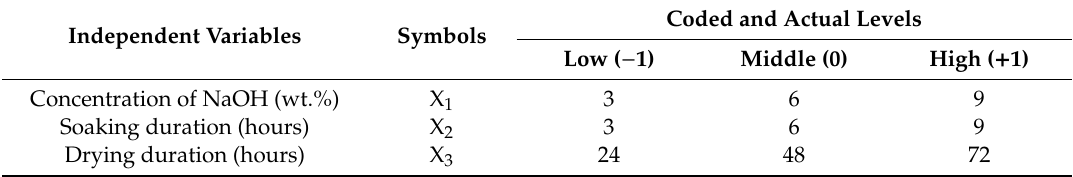
Coded and Actual Levels Low ( − 1) Middle (0) High ( + 1)